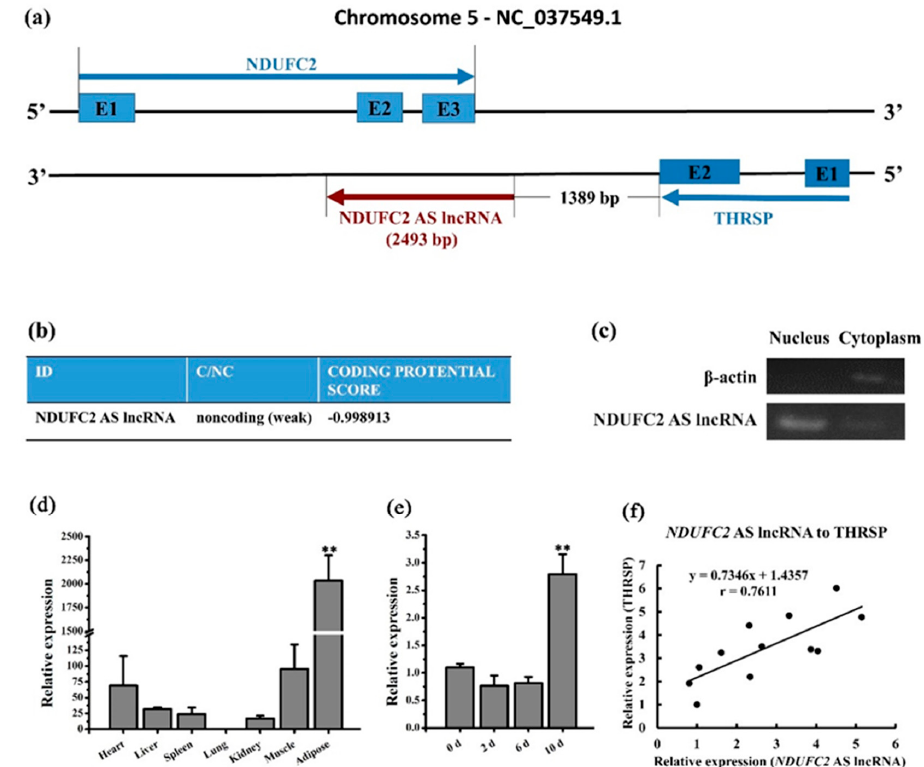
Figure 4. Characterization of NDUFC2 -AS lncRNA. ( a ) Positional relationship among NDUFC2, NDUFC2 -AS lncRNA, and THRSP in buffalo genome. ( b ) Protein coding ability prediction of NDUFC2 -AS lncRNA by Coding Potential Calculator (CPC) program. ( c ) Cell localization of NDUFC2 -AS lncRNA by semiquantitative PCR. RNA was isolated from nuclear and cytoplasmic fractions of adipose tissue. β -actin mRNA was used as control. ( d ) Tissue expression profile NDUFC2 -